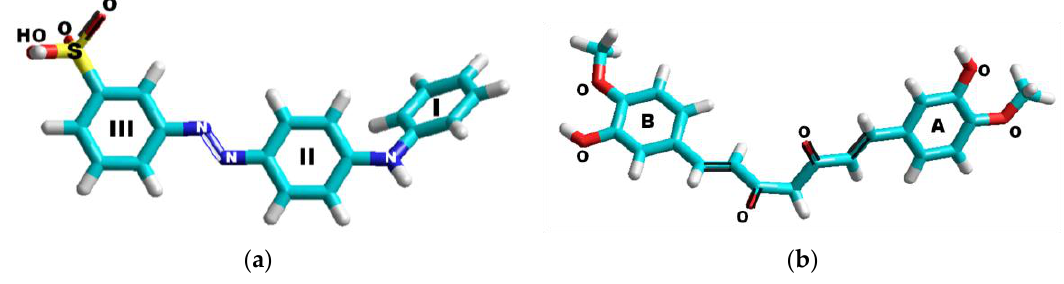
Figure 1. Chemical structure of: Metanil yellow ( a ), and Curcumin/Turmeric ( b ).